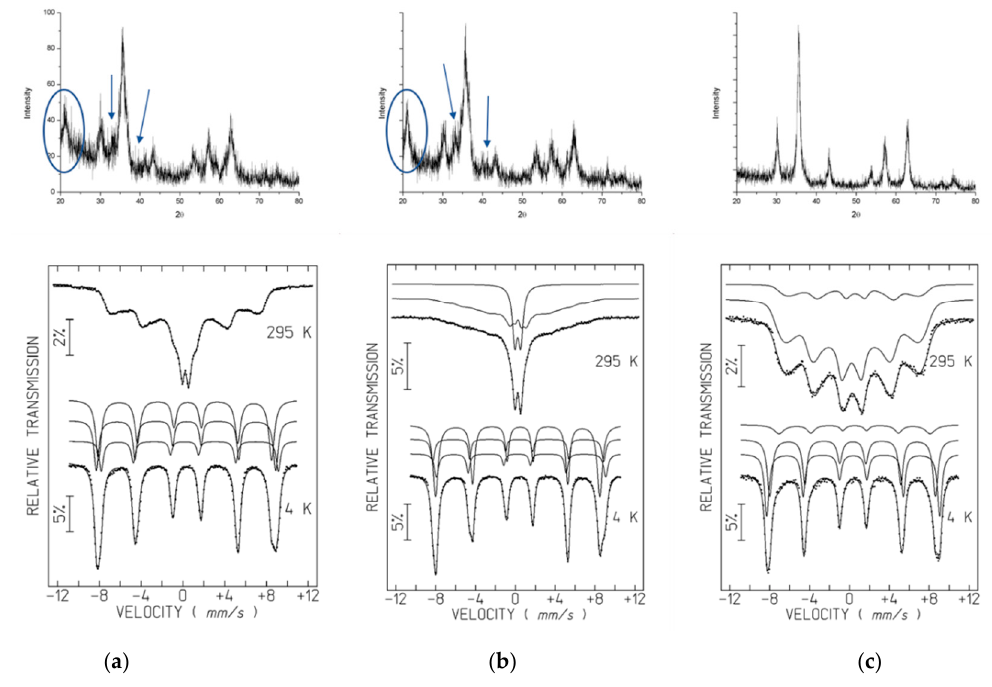
Figure 4. XRD diffractograms and Mössbauer spectra of naked SPIONs: ( a ) A 1.1, ( b ) A 2.1, ( c ) A 3.2.